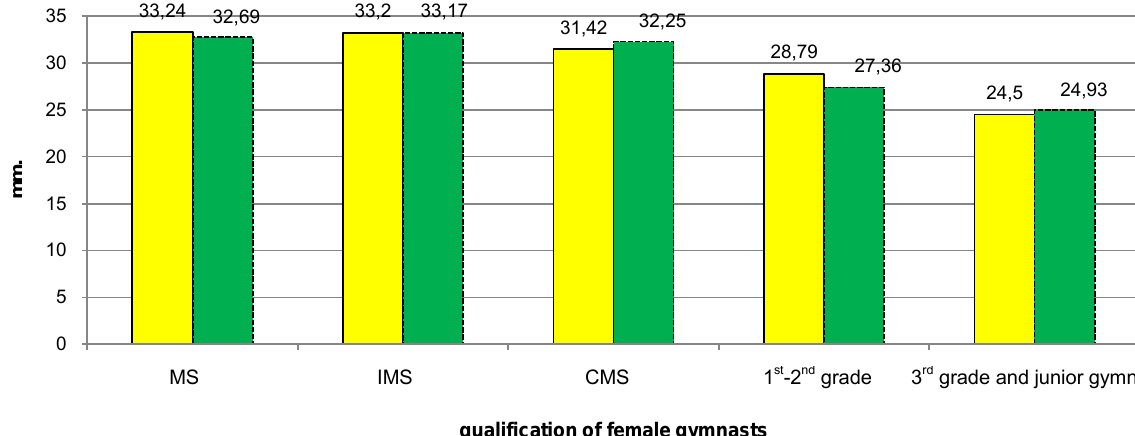
Fig.2. Correlation of indicators of feet’s flattening of female gymnasts on different stages of many years training in